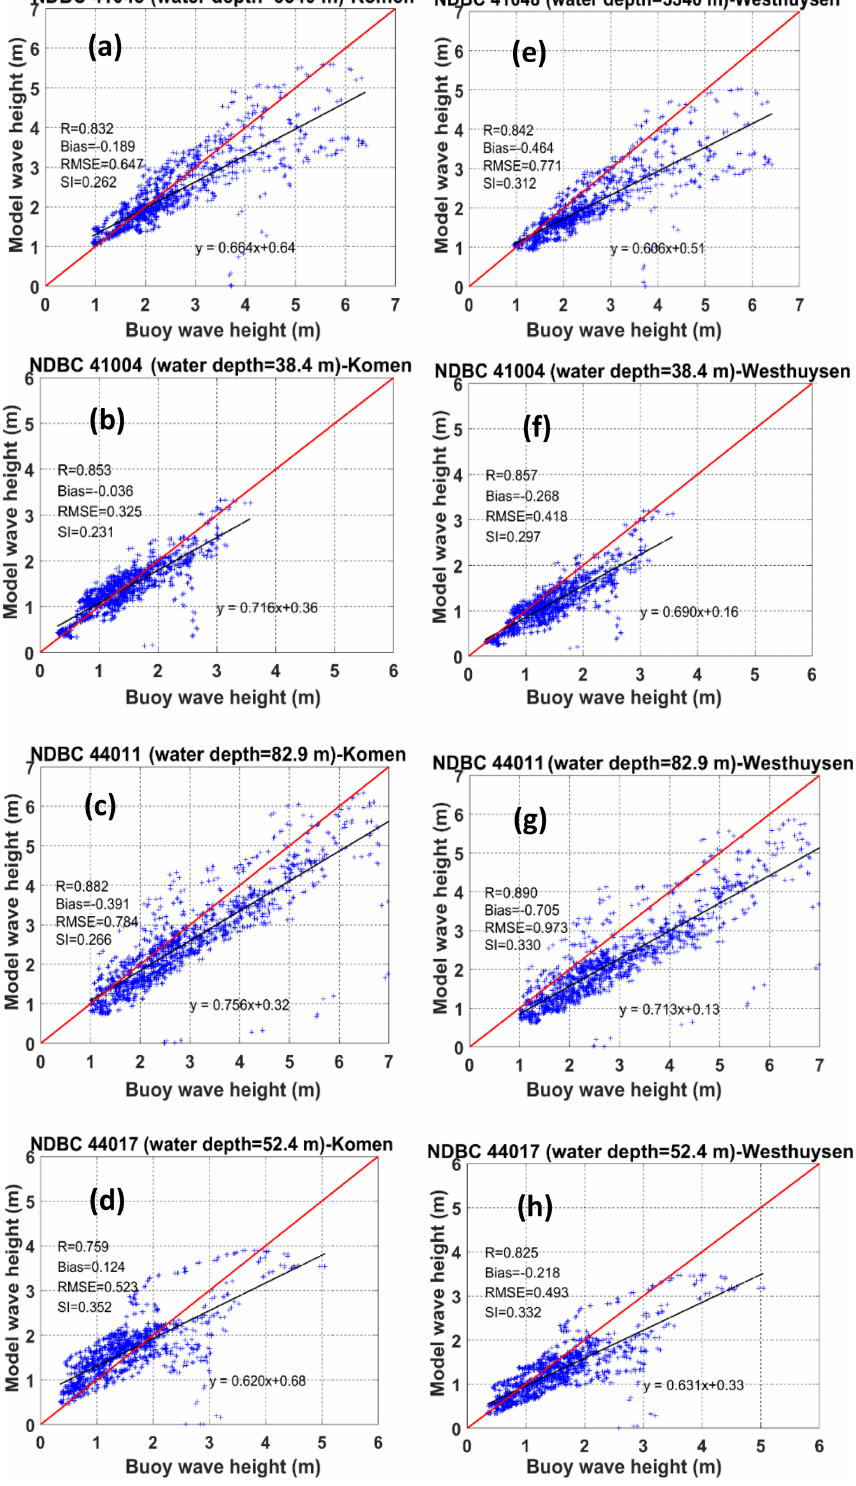
Figure 7. Scatter plots and model performance metrics for simulated wave heights using (a–d) Komen whitecapping and (e–h) Westhuysen whitecapping at the NDBC buoys. The red and black lines are the 1 : 1 line and regression line,